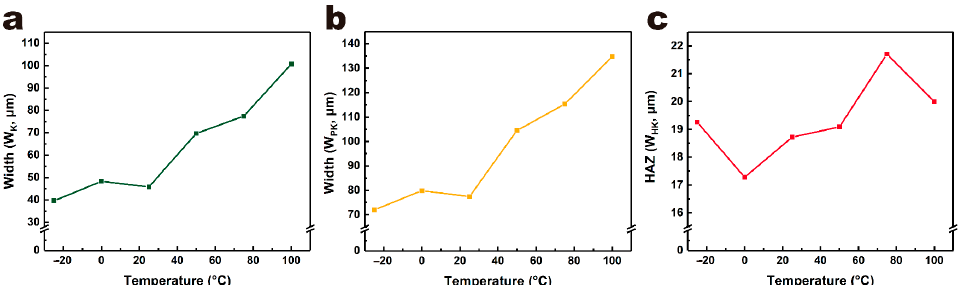
Figure 11. Kerf width ( a ), processing area width ( b ) and HAZ ( c ) of PET films at different ambient temperatures in line laser processing experiment.